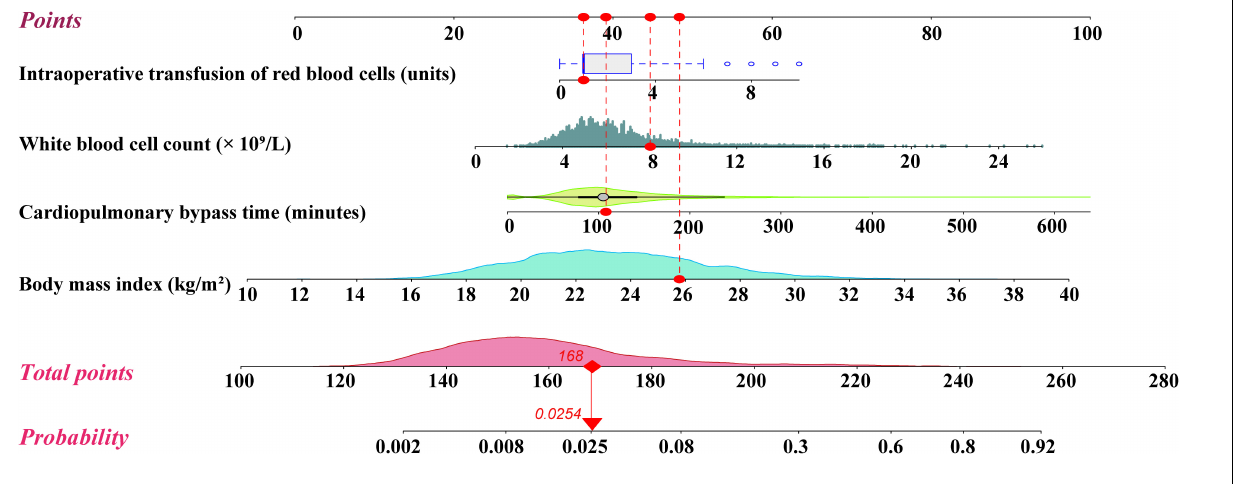
FIGURE 1 | Nomogram for the prediction of severe hypoxemia after cardiac